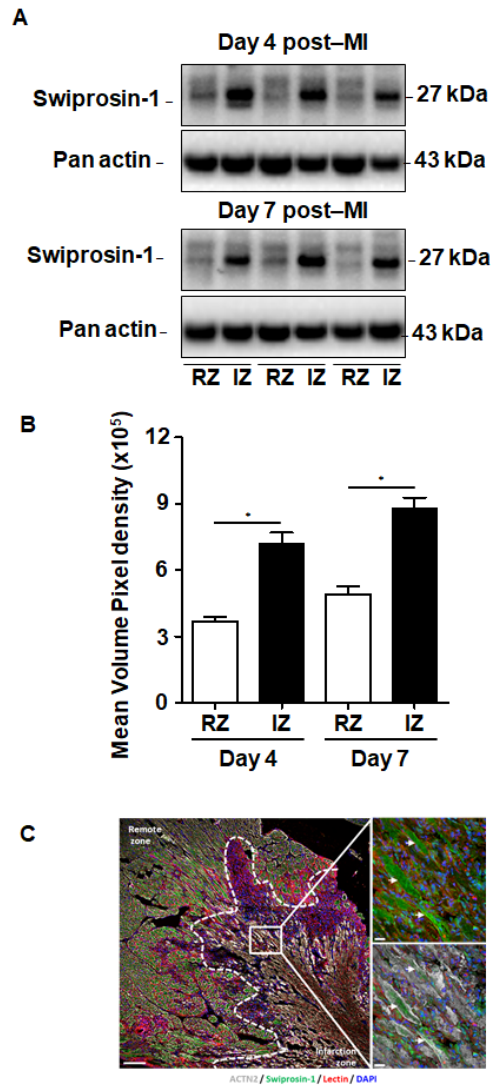
Figure 1. Expression of swiprosin-1 after the onset of myocardial infarction in adult mice. ( A ) Representative Western Blot analysis of swiprosin-1 in myocardial tissue from adult mice fractionated in noninfarct remote zone (RZ) and infarction zone (IZ) at days 4 and 7 after myocardial infarction (post-MI). ( B ) Quantification of the two Western Blots showed by A with *, p < 0.05 vs. RZ; ( C ) Immunofluorescence analysis of swiprosin-1 (green) in infarcted hearts from mice 4 days post-MI. Viable cardiomyocytes were stained with ACTN2 (grey) and lectin (red). 4 ′ ,6-diamidino-2-phenylindole (DAPI) was used for nuclear staining (blue). White arrows classify swiprosin-1 immunopositive cardiomyocytes. Scale bars: 100 µm and 20 µm in magnified sections.